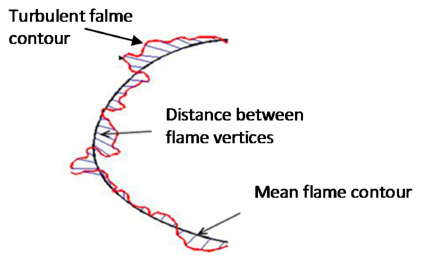
Figure 6. Displacement of turbulent flame contour vertices from mean contour.